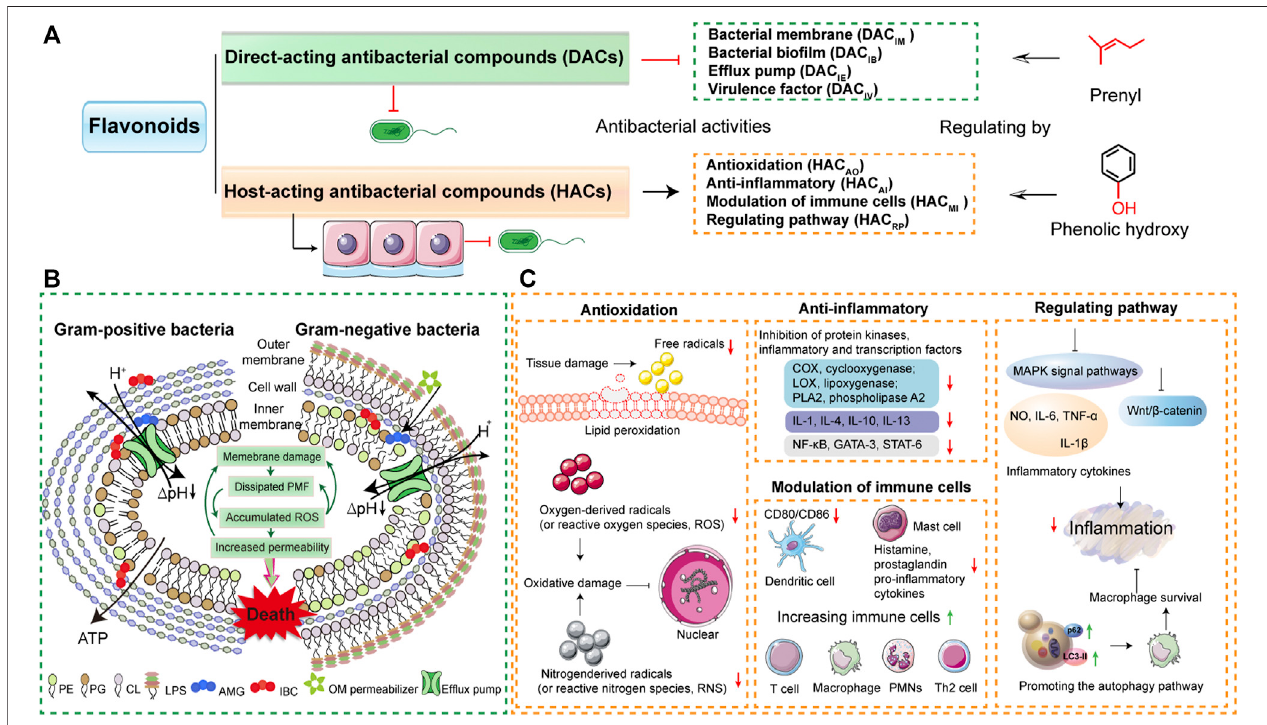
FIGURE 4 | Modes of action of fl avonoids on resistant pathogens. (A) The fl avonoids are divided into two types of compounds based on the antibacterial modes. One is the direct-acting antibacterial fl avonoid compounds (DACs) that damage the bacterial membrane and inhibit bacterial bio fi lm, bacterial ef fl ux pump, or virulence factor. The other refers to host-acting antibacterial fl avonoid compounds (HACs) that target anti-in fl ammatory, antioxidation modulation of immune cells, or regulate cellular pathway. The antibacterial activities of DACs and HACs are regulated by prenyl, phenolic hydroxy, or methyl. (B) The mechanisms of fl avonoid DAC (isobavachalcone, AMG and α -mangostin, IBC) inhibit bacterial membrane (Song et al., 2021a). The copyright was obtained from Wiley-VCH GmbH in their journal of Advanced Science with the terms of the https://creativecommons.org/licenses/by/4.0/license. (C) The molecular mechanisms of fl avonoid HACs have the antibacterial actions of antioxidation, anti-in fl ammatory, modulation of immune cells, and regulating cellular pathway.